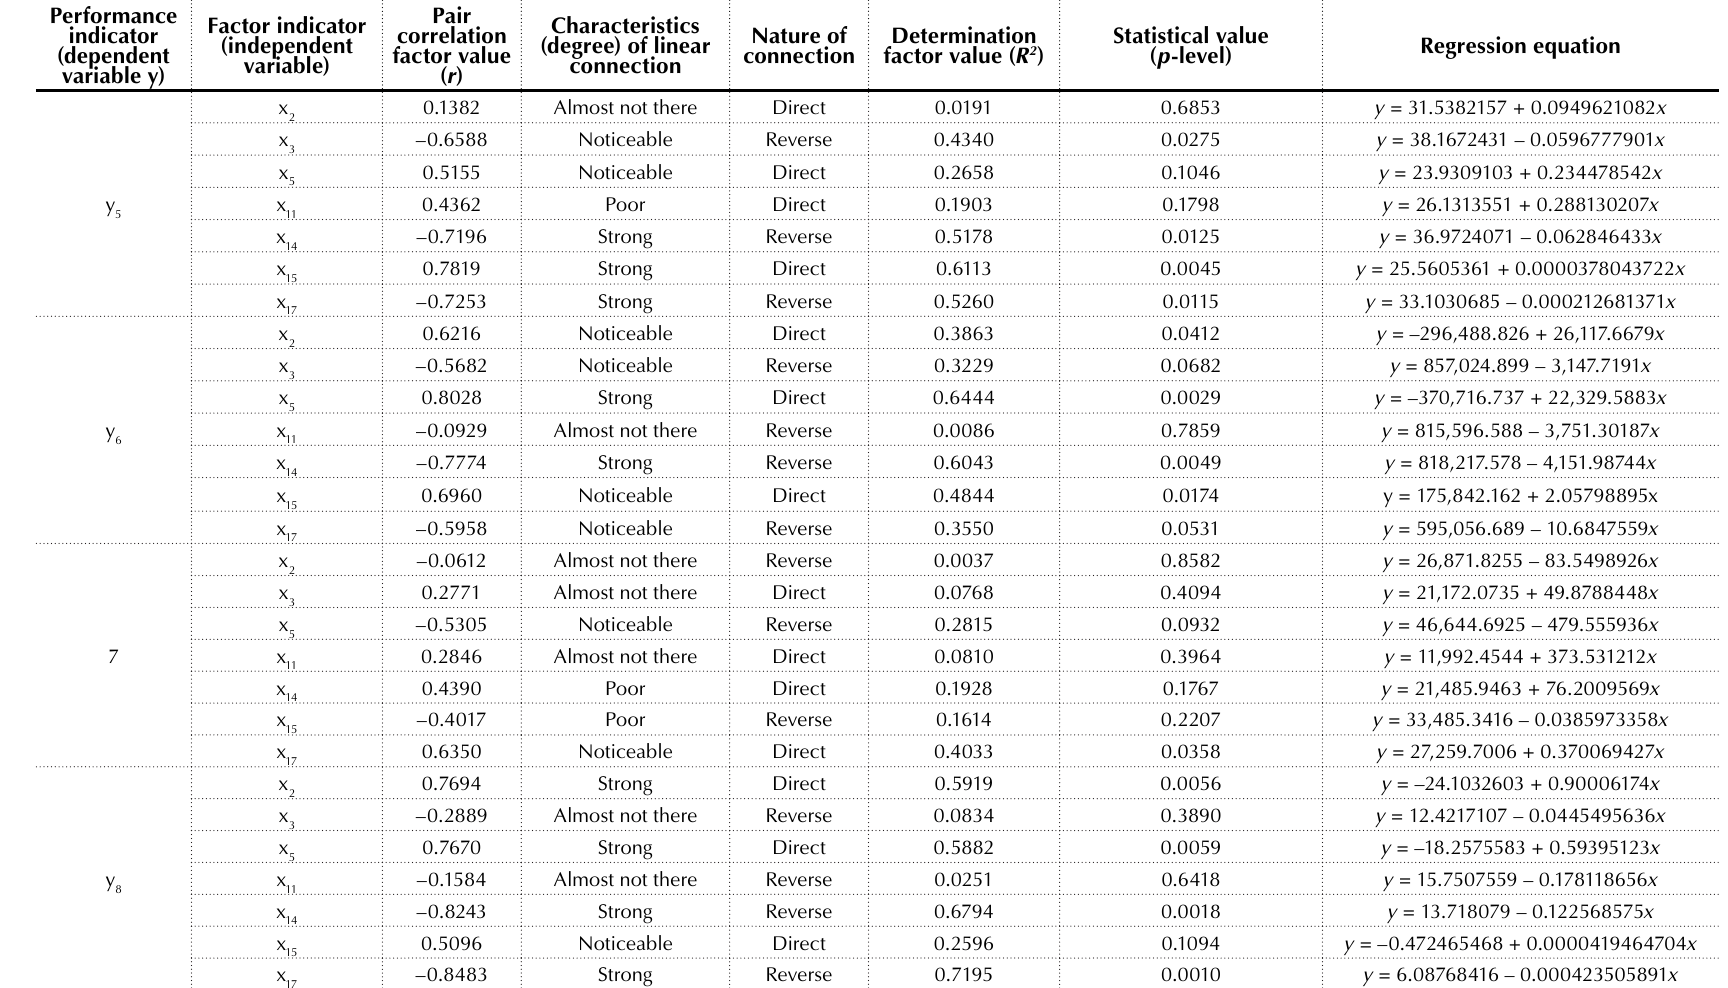
Table 4A (cont.). The nature and value of influence of foreign banking indicators (factors) on the indicators of financial and economic security of Ukraine (indicators under